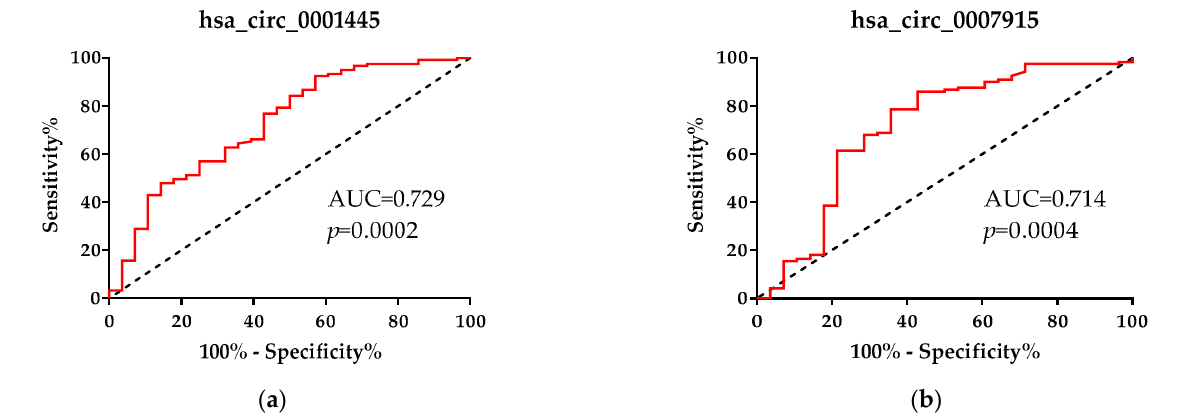
Figure 2. ROC analysis and ROC curves using ( a ) hsa_circ_0001445 and ( b ) hsa_circ_0007915 to differentiate patients with CRC in stage IV from patients in stage III.